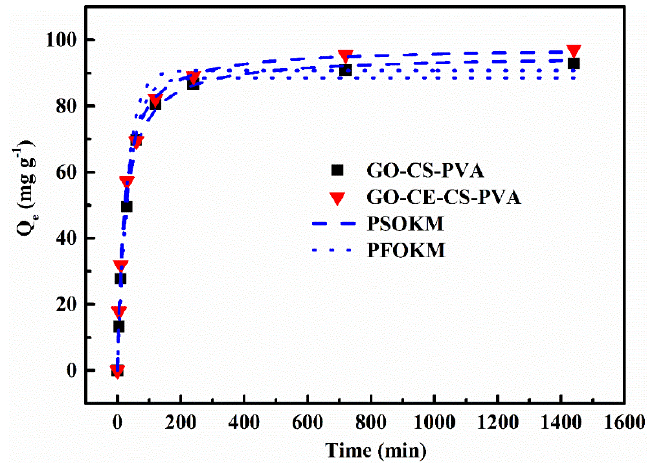
Figure 7. The adsorption kinetic data and model of Li + by GO–CE–CS–PVA and GO–CS–PVA. Table 1. PFOKM and PSOKM parameters of GO − CE − CS − PVA and GO − CS − PVA.